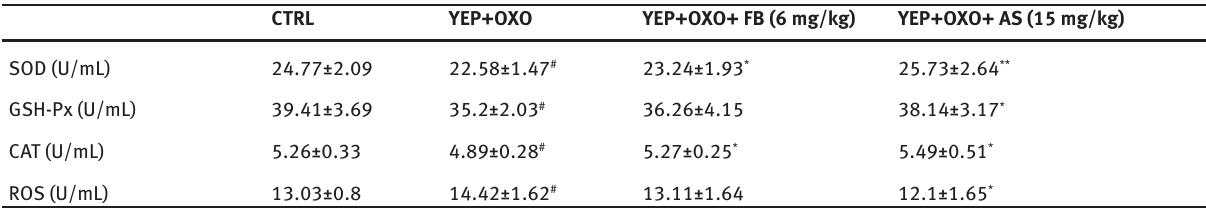
Table 1: The effects of FB and AS on anti- and pro-oxidation cytokines in mice with hyperuricemia. CTRL YEP+OXO SOD (U/mL)